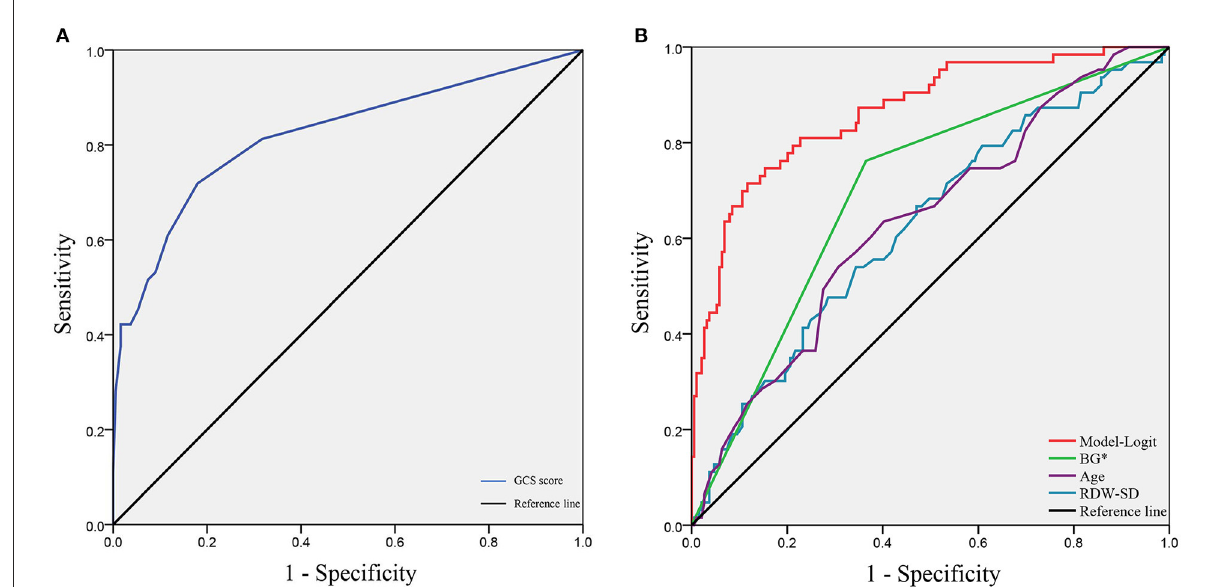
FIGURE3 ROC analysis of the Model-Logit and independent risk factors. (A) GCS score as a protective role with the AUC of 0.819; (B) AUCs of the Model-Logit, BG*, age, and RDW-SD are 0.865, 0.698, 0.634, and 0.625, respectively. Model-Logit, logistic model; GCS score, Glasgow coma